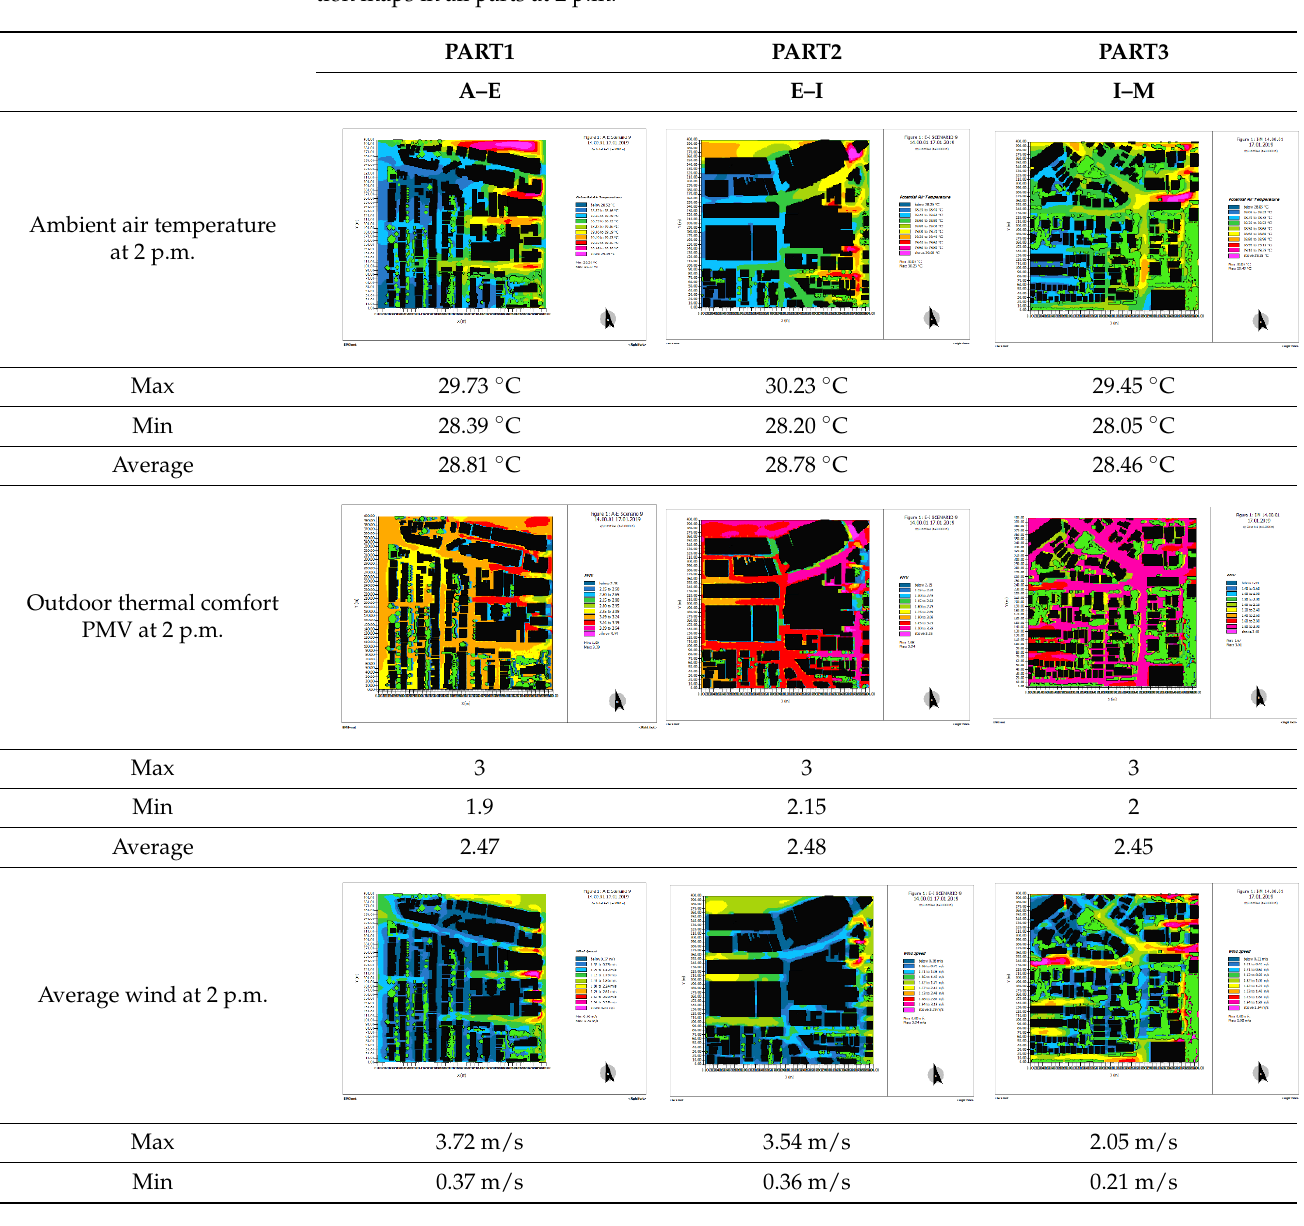
Table 16 shows the ambient air, outdoor thermal comfort, and wind speed distribution maps at 2 p.m. Table 16. Scenario nine ambient air temperature, outdoor thermal comfort, and wind speed distribu- tion maps in all parts at 2